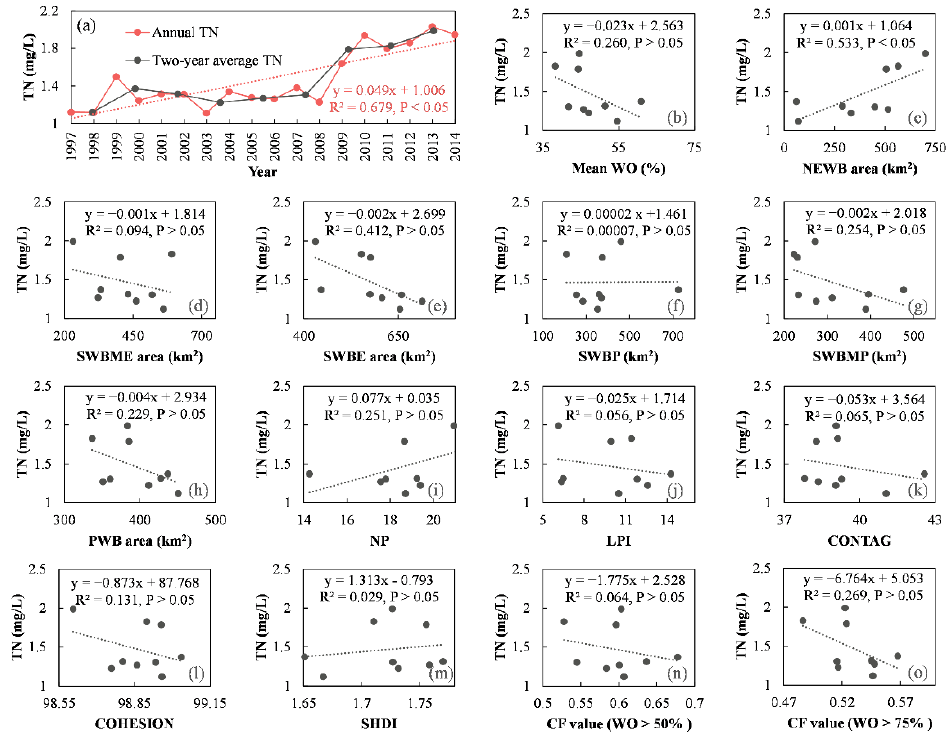
Figure 10. The relationship between water occurrence changes and total nitrogen in Dongting Lake. ( a ) indicates the time series of TN, ( b ) indicates the relationship between mean WO and TN, ( c – h ) indicate the relationship between water body areas of different types and TN, ( i – m ) indicate the relationship between landscape indices and TN, and ( n , o ) indicate the relationship between hydrological connectivity and TN. The WO was calculated on a two-year scale; therefore, the study calculated the two-year average TN series for linear regression analysis.